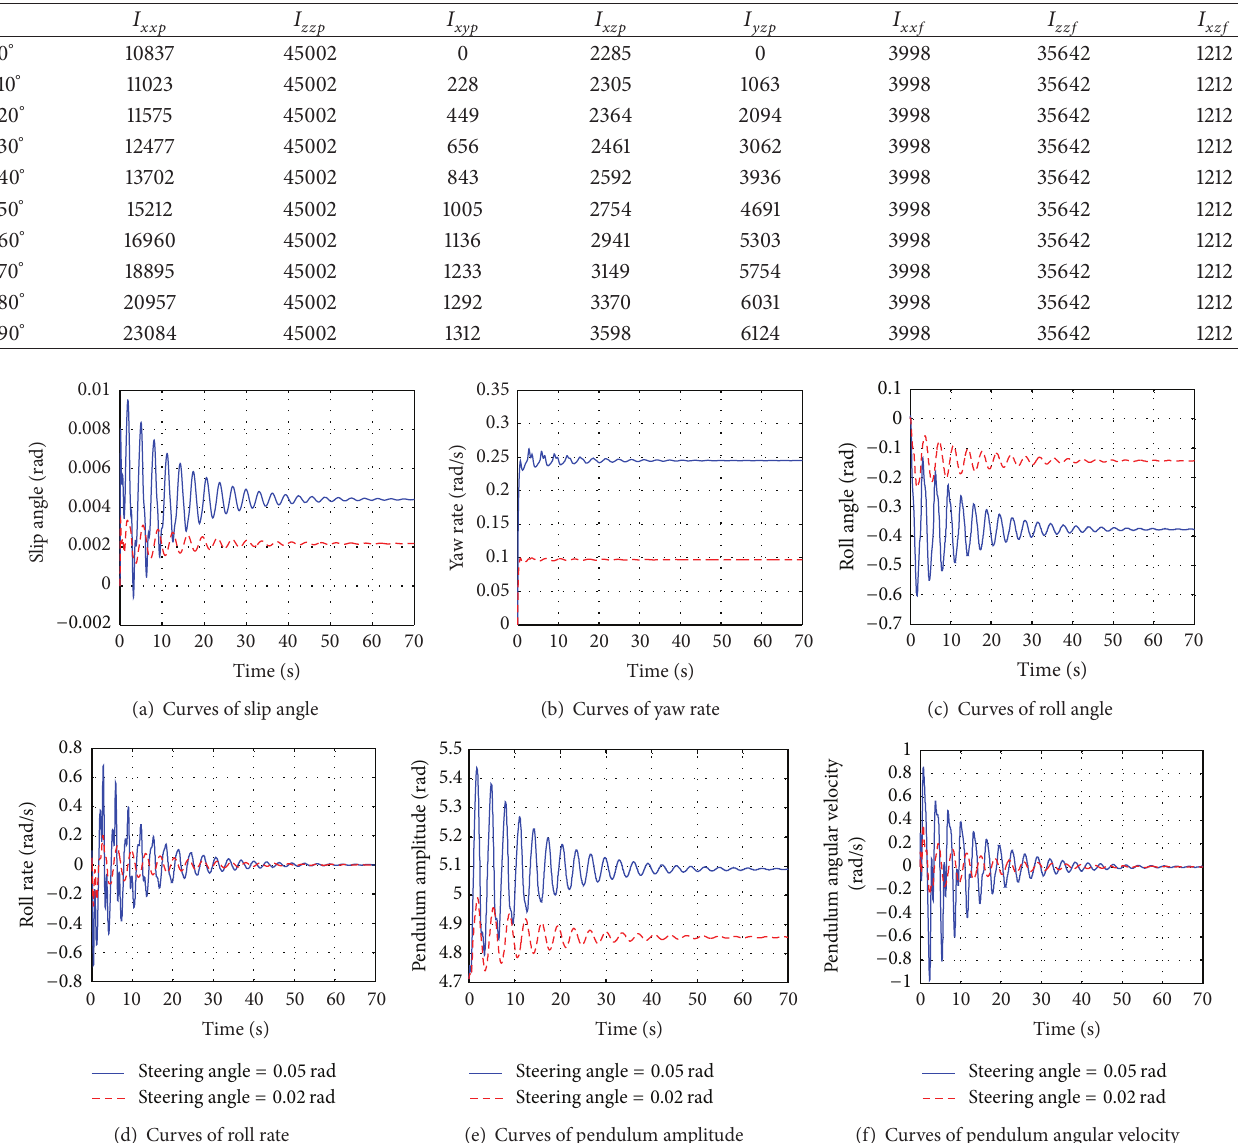
Figure 9: Truck driving stability when liquid fill level is